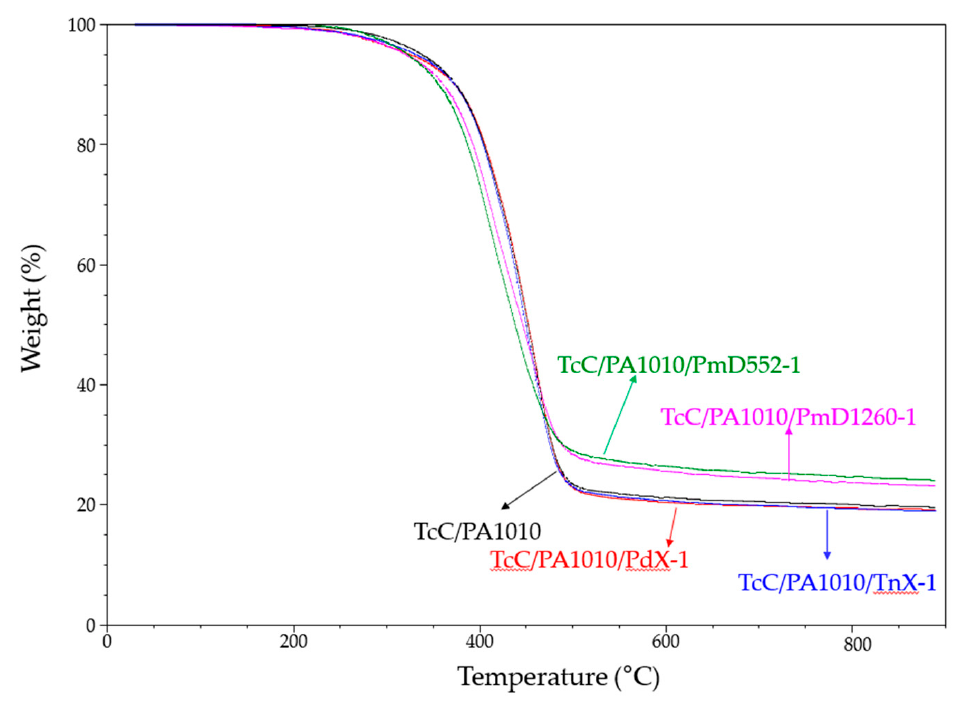
Figure 6. TGA curves of TcC/PA1010 and TcC/PA1010/cross-linker blends under flowing nitrogen.